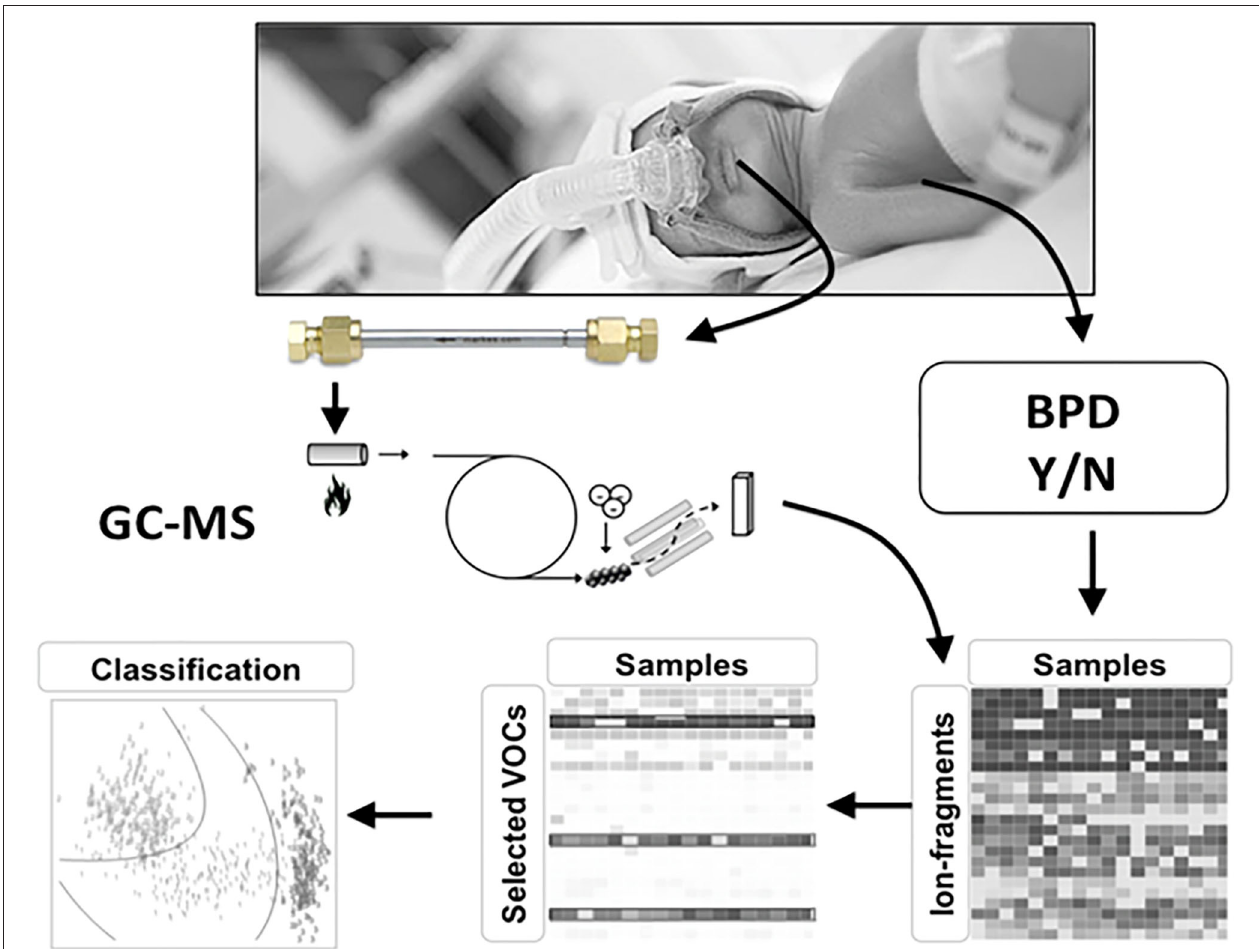
FIGURE 3 | Study design for developing BPD specific eNose. Volatile organic compounds (VOCs) are absorbed onto a stainless-steel tube containing Tenax GR 60/80 (Interscience, Breda, The Netherlands) for 5min at a flow rate of 50 ml/min. The captured VOCs in the tubes are released by re-heating the tubes after which the fragment ions are detected using a quadrupole mass spectrometer (GCMS-GP2010; Shimadzu, Den Bosch, The Netherlands) with a scan range of 37–300 Da. Ion fragment peaks were used for statistical analysis. GC-MS analysis will be performed in all